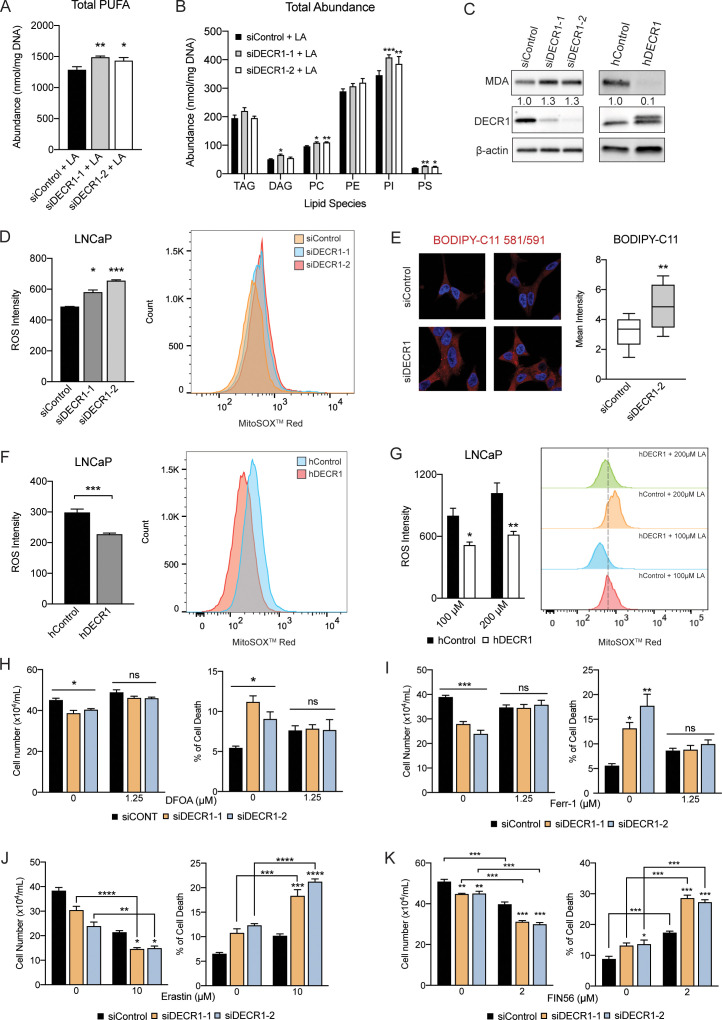
DECR1 knockdown induces PUFA accumulation, lipid peroxidation and ferroptosis.(A) Abundance of total PUFAs and (B) total abundance of lipid species in phospholipids from control and DECR1 knockdown cells supplemented with linoleic acid (LA). (C) Malondialdehyde (MDA), an oxidative stress marker, was measured by western blot in LNCaP cells transfected with DECR1 siRNAs and in DECR1-overexpressed LNCaP cells. (D) Mitochondrial superoxide levels were quantified following 96 hr DECR1 knockdown using MitoSOX red stain. Fluorescent intensity was quantified using flow cytometry and ROS levels presented as mean fluorescent intensity. (E) Fluorescent images of BODIPY-C11 stained LNCaP cells following DECR1 knockdown (left). Fluorescent intensity was quantified using ImageJ and presented as mean fluorescent intensity (right). (F) Mitochondrial superoxide levels were quantified in stable DECR1-overexpressing LNCaP cells using MitoSOX red stain under basal or (G) linoleic acid (100 µM or 200 µM) conditions. Fluorescence intensity was quantified using flow cytometry and ROS levels were presented as mean fluorescent intensity. Cell viability of LNCaP cells after 48 hr DECR1 knockdown, treated with (H) deferoxamine (DFOA, 1.25 µM), (I) ferrostatin (Ferr-1, 1.25 µM), (J) erastin (10 µM), or (K) FIN56 (2 µM). Data in bar graphs are represented as the mean ± s.e.m. Statistical analysis was performed using two-tailed Student’s t-test (A-G) or one-way ANOVA, followed by Holm-Sidak's multiple comparisons test (H-K): ns, not significant, *p<0.05, **p<0.01, ***p<0.001 and ****p<0.0001. TAG: triacylglycerol; DAG: diacylglycerol; PC: phosphotidylcholine; PE: phosphotidylethanolamine; PI: phosphatidylinositol; PS: phosphotidylserine.